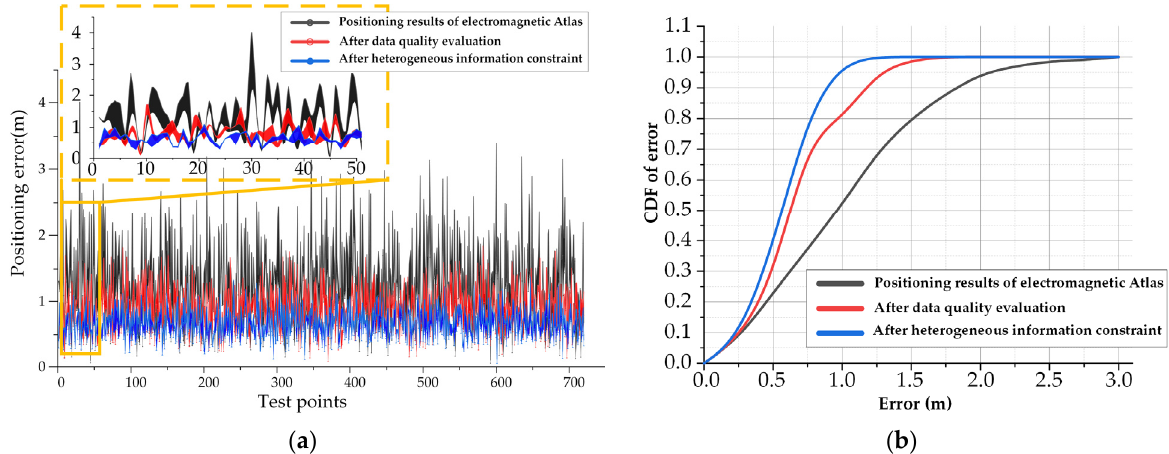
Figure 19. Error Analysis: ( a ) Error band; ( b ) Error cumulative distribution function.